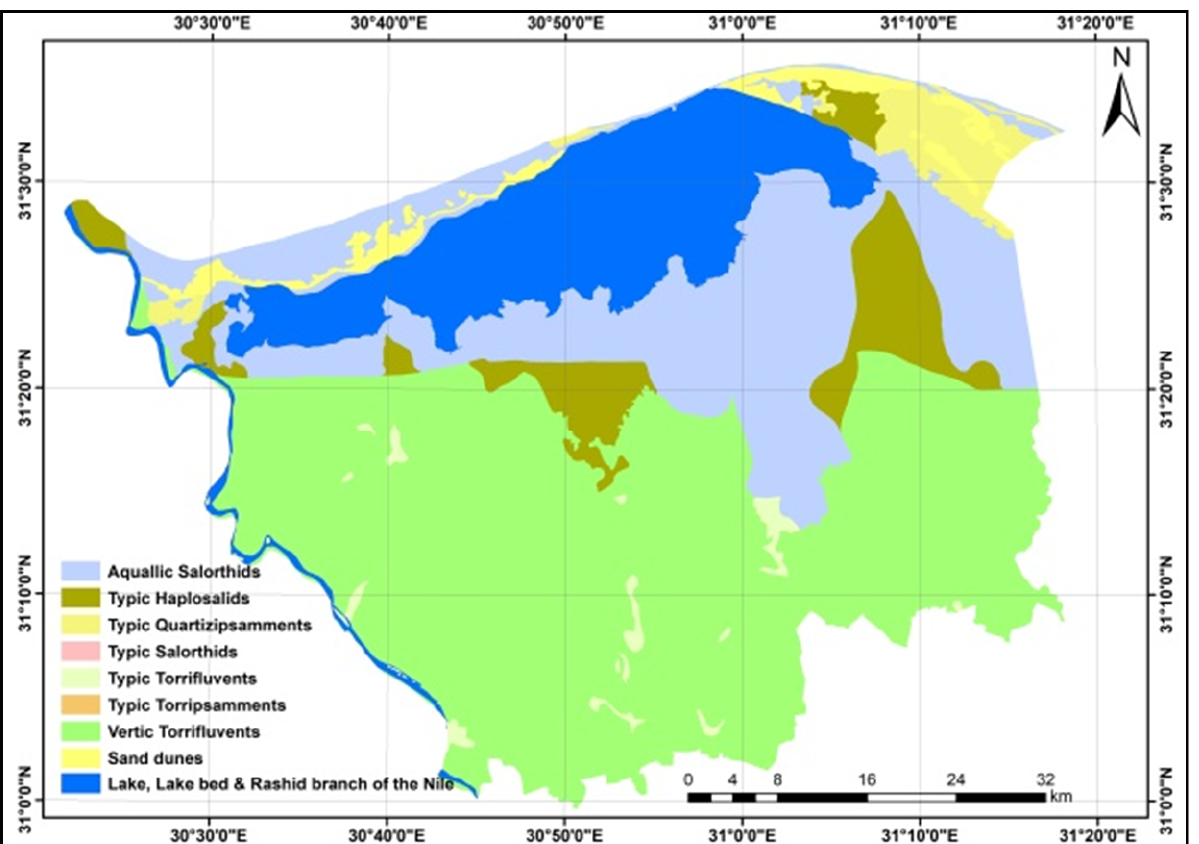
Figure 6. Soil taxonomy units of the study area,